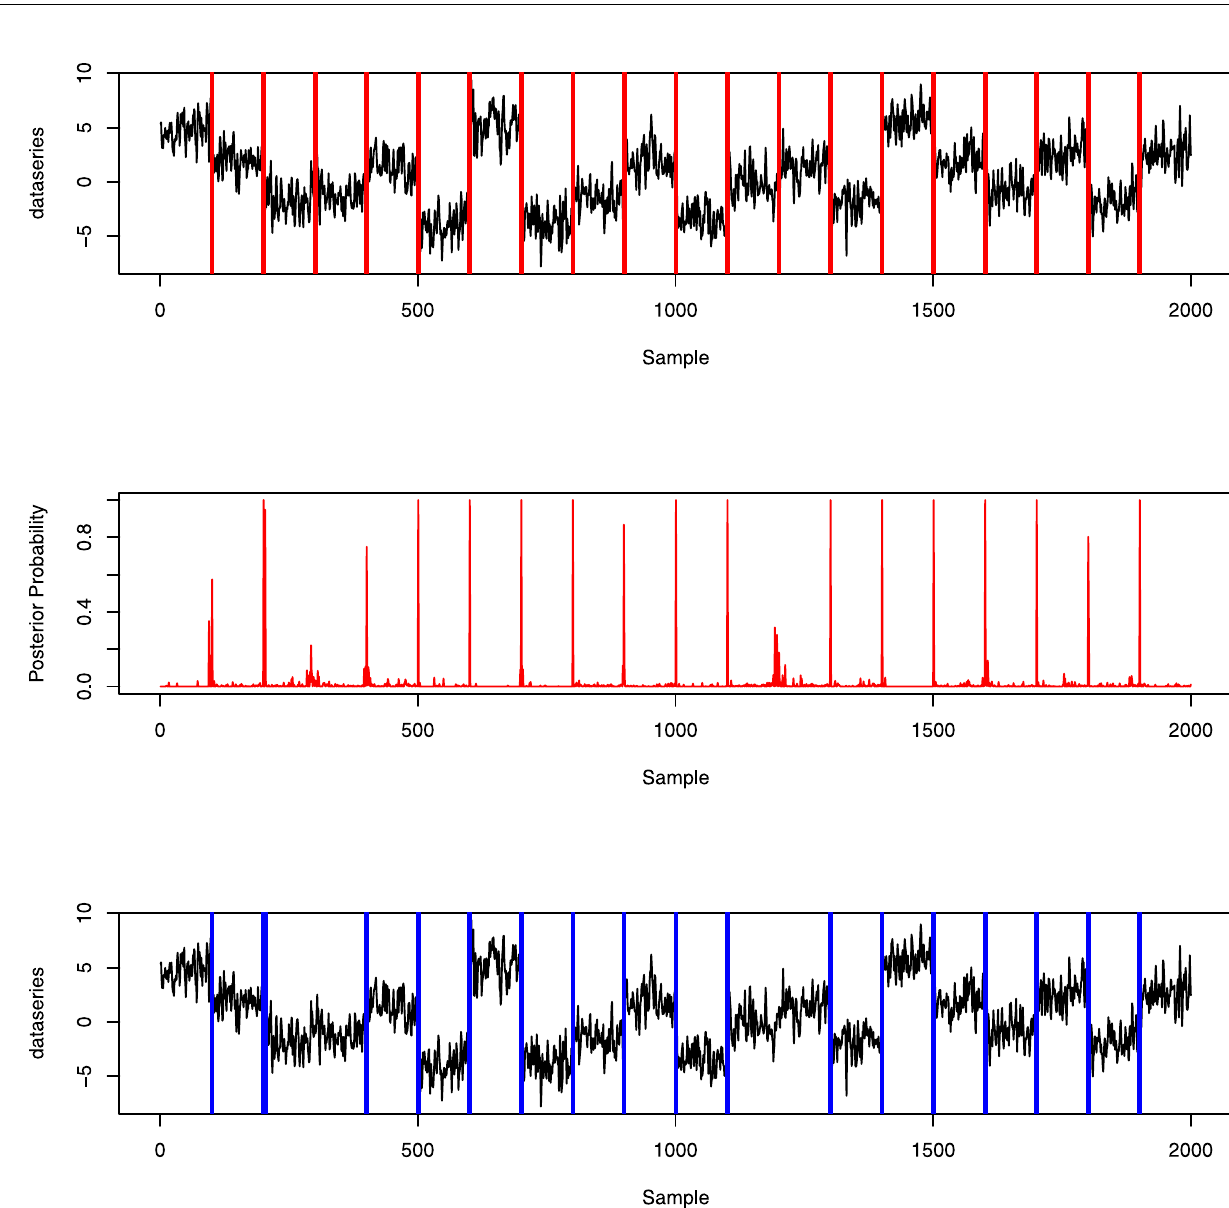
Fig 6. (Top) Segmented signal with the true change-point locations. (Middle) Posterior probabilities of occurrence of change-points. (Bottom) Estimated change-point locations (posterior probability greater than 0.5). The middle plot shows the location of peaks in the probability profile closely follows the true change-points locations but in some positions with low posterior probability. Using a threshold in posterior probability 0.5, we identify 17 change-points out of 19 which match the locations of the true